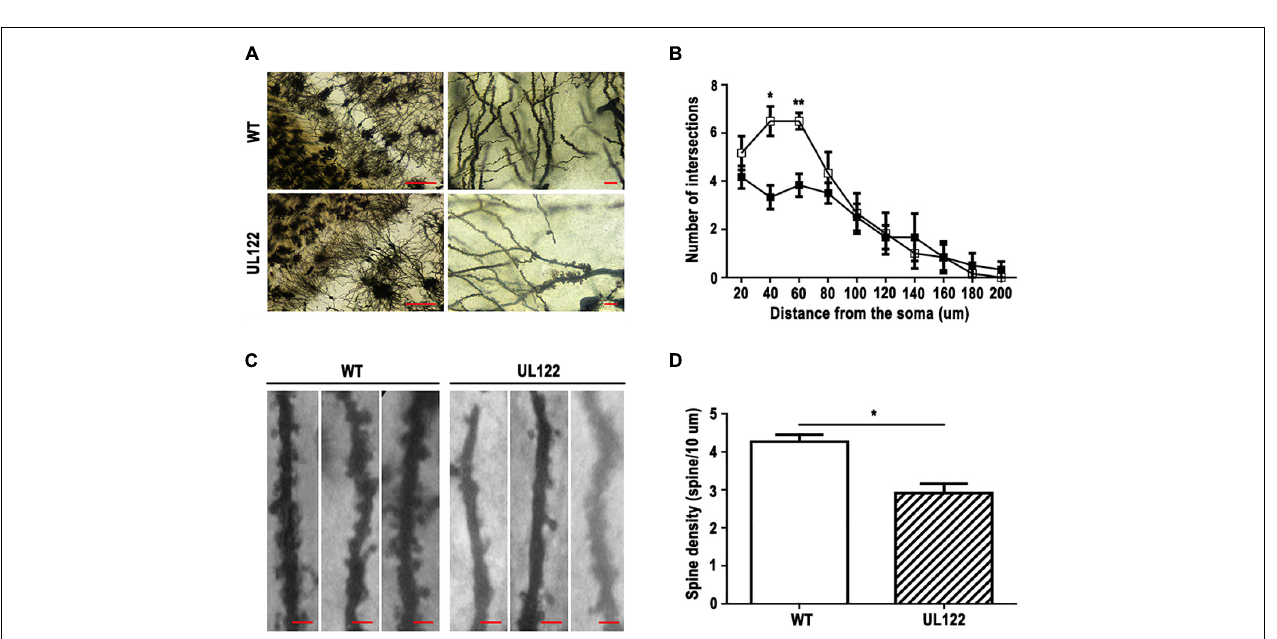
FIGURE 4 | Golgi staining in the hippocampal CA1 region of UL122 mice aged 12 months. (A,B) Representative Golgi-Cox staining of the hippocampal CA1 region (scale bar on the left: 100 µ m, scale bar on the right: 10 µ m) and quantification of the number of dendritic branches. (C,D) Representative Golgi-Cox staining (scale bar: 10 µ m) and quantification of the dendritic spine density. All data were presented as mean ± SEM( n = 10 neurons per mouse, 6 mice per group). Statistical analysis was performed by unpaired t -test. * P < 0.05, ** P < 0.01 vs. the control